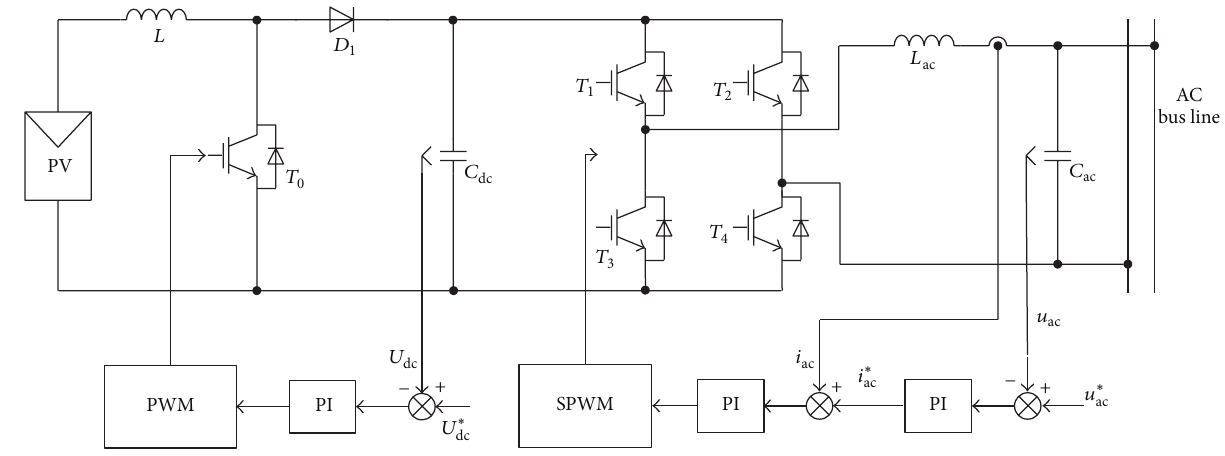
Figure 5: The control system structure of PV